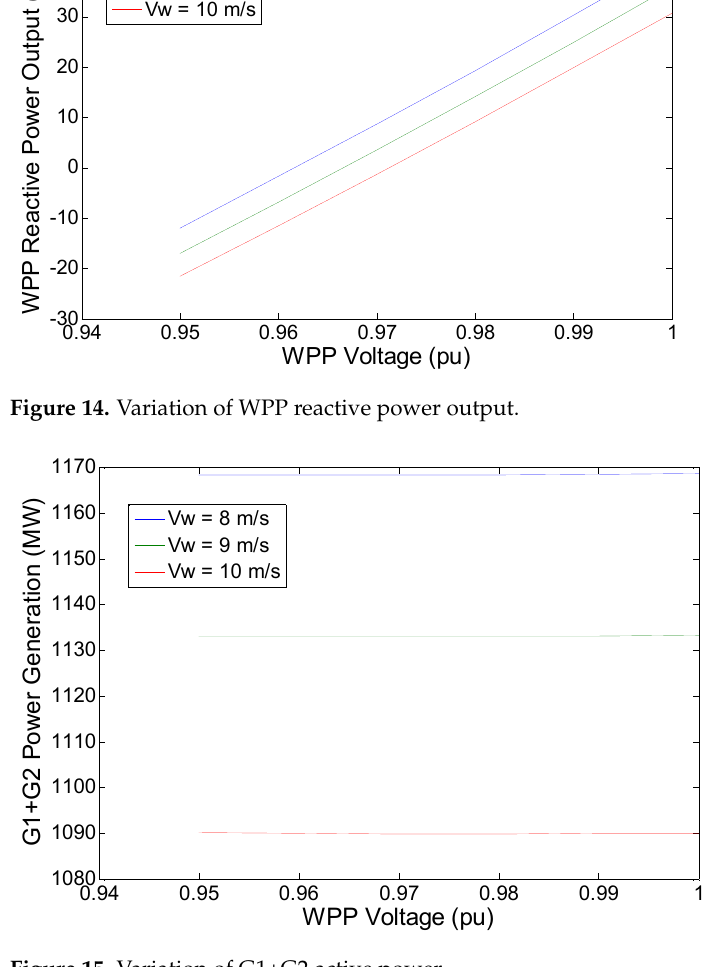
Figure 15. Variation of G1+G2 active power.